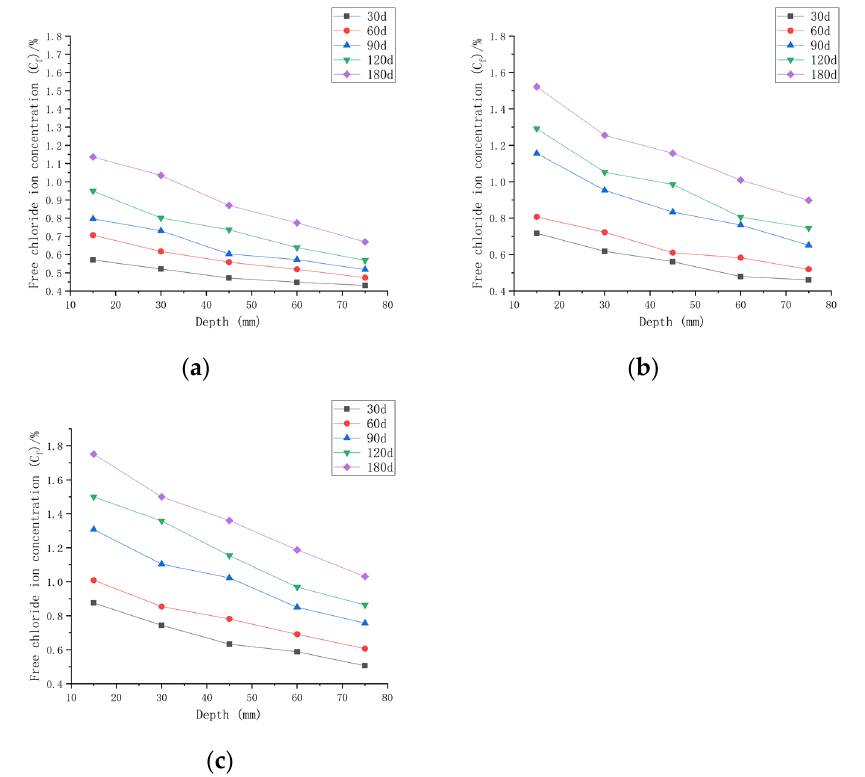
Figure 8. Relationship between free chloride ion concentration and depth of CASC with water–cement ratio of 0.35 at different test times and loads. ( a ) Load is 0; ( b ) load is 0.1; ( c ) load is 0.2.